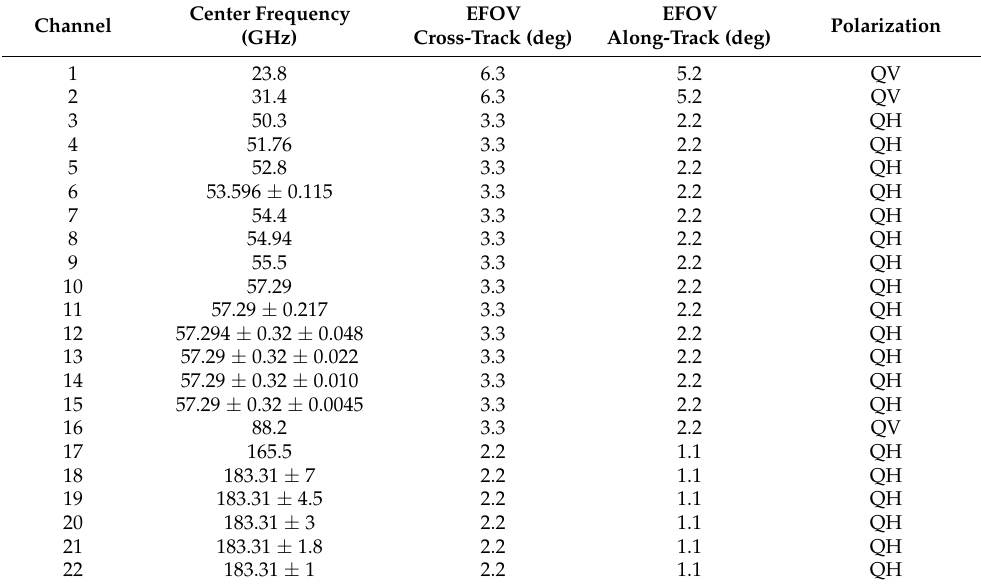
Table 1. Characteristics of ATMS channels (https://www.star.nesdis.noaa.gov/jpss/ATMS.php, accessed on 2 February 2022).